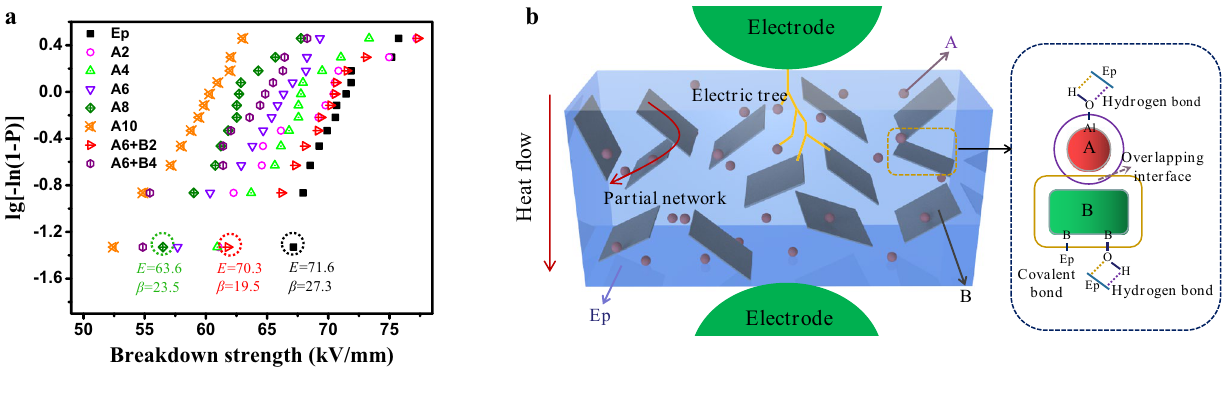
Figure 5. ( a ) Dielectric breakdown strength of pure epoxy and its composites based on Weibull distribution. ( b ) Schematic diagram of breakdown processing in epoxy composites with hybrid